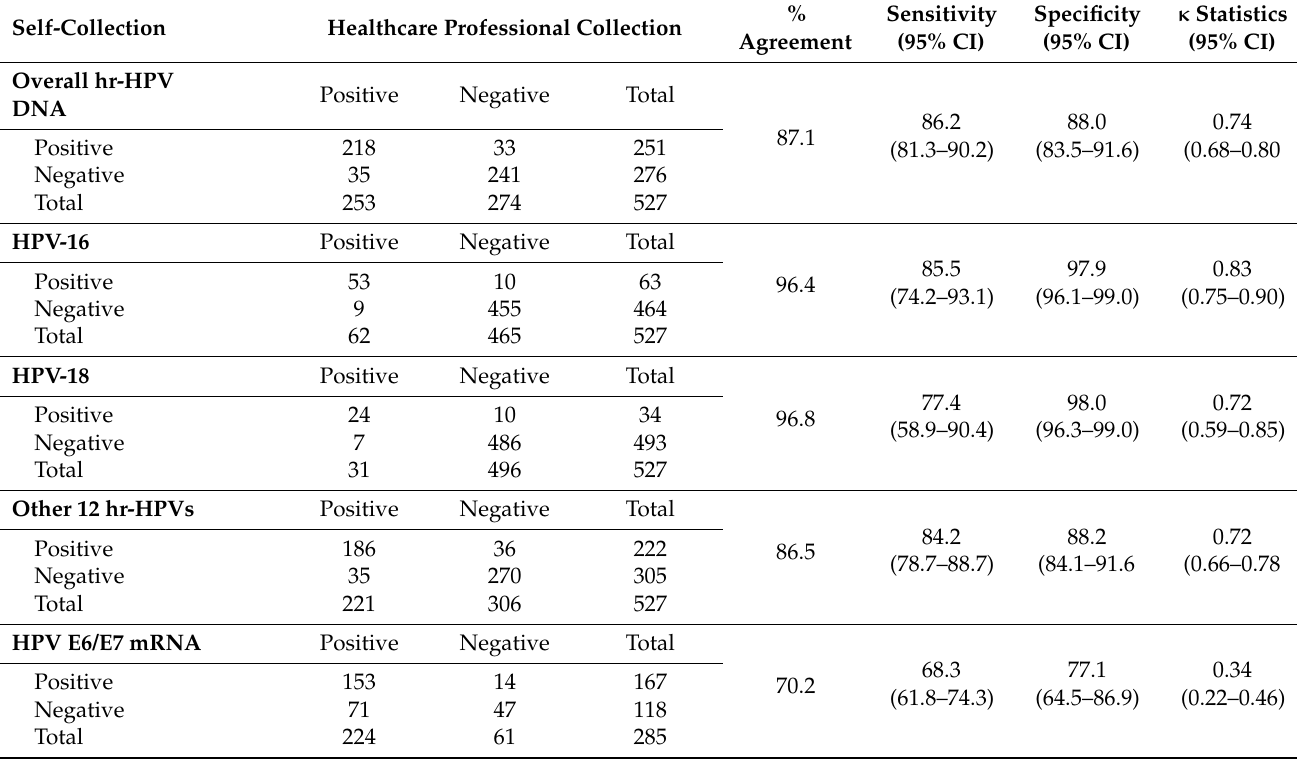
Table 2. Performance of hr-HPV and HPVE6/E7 mRNA self-sampling relative to healthcare professional sampling. Self-Collection